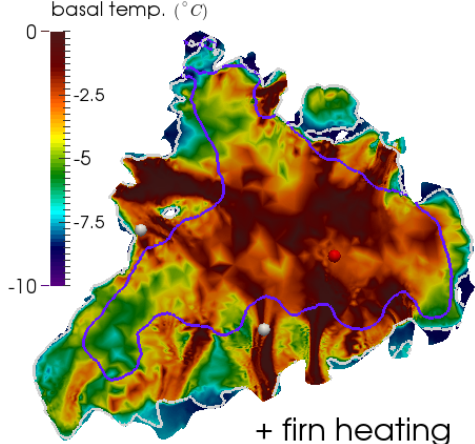
Figure 8. Temperature profile as measured (red) in a drill hole (Mo- toyama et al., 2008) (temperatures relative to pressure melting), the position is indicated in Fig. 6 (red dot). The dotted black line cor- responds to the depth-dependent profile, the green line corresponds to the modelled temperature field including only strain and friction heating. The dark blue line is the result of the equilibrium firn heat- ing simulation with the first set of parameters (percolation depth of 13.2m, simulation firnss ), which acted as initial profile for the succeeding transient runs. The orange, cyan and pink profiles illus- trate the evolution of temperature in the succeeding time-evolving simulation with the second set of parameters (percolation depth of 17.6m) evolving towards a new equilibrium (grey line). The best fit to the data among these profiles after 35yr is highlighted in black (simulation firnevol ).